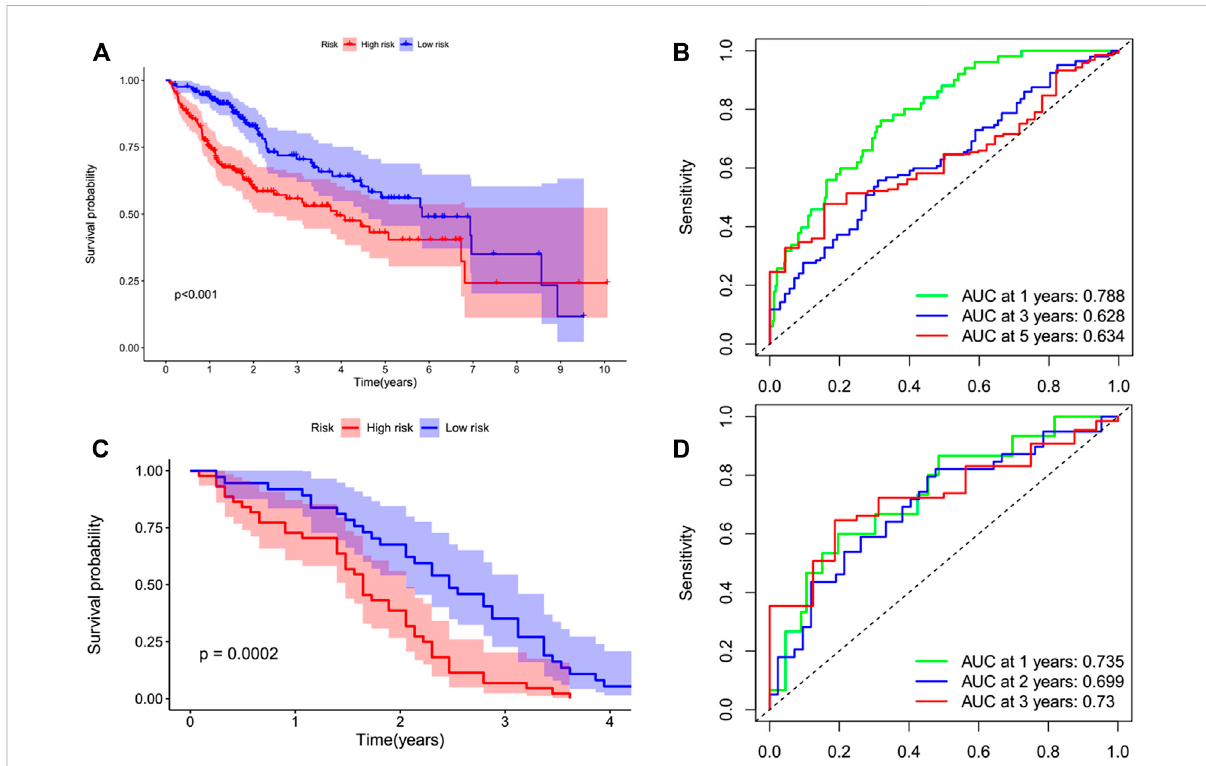
FIGURE 6 Kaplan – Meier survival analysis of the prognostic model. Invalids in both datasets were divided into high-risk (red) and low-risk (blue) groups, applying the median risk score as the threshold. (A,B) In the TCGA cohort, the survival probability of the low-risk group was higher than that of the high-risk group ( p < 0.001). The AUCs at 1-, 3-, and 5-years were 0.788, 0.628, and 0.634, respectively. (C,D) This prognostic model was veri fi ed in theGEO cohort. The survival probabilityoflow-risk group washigher than that ofhigh-risk group ( p = 0.0002). TheAUCs at1 year,2years, and 3 years were 0.735, 0.699, and 0.73,